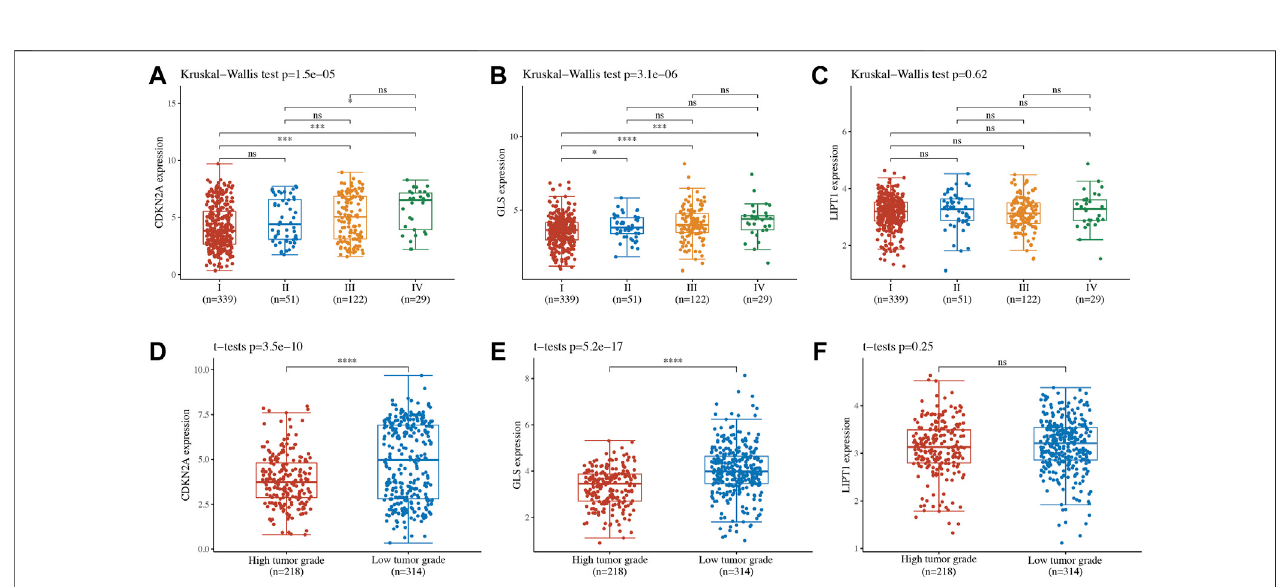
FIGURE 6 | Development of a predictive nomogram. (A,B) Univariate and multivariate Cox regression considering clinical parameters and cuproptosis-related prognostic biomarkers. (C,D) Predictive nomogram to predict the 3- and 5-year survival of uterine corpus endometrial carcinoma patients. Calibration curve for the survival nomogram model in the discovery group. A dashed diagonal line represents the ideal nomogram.